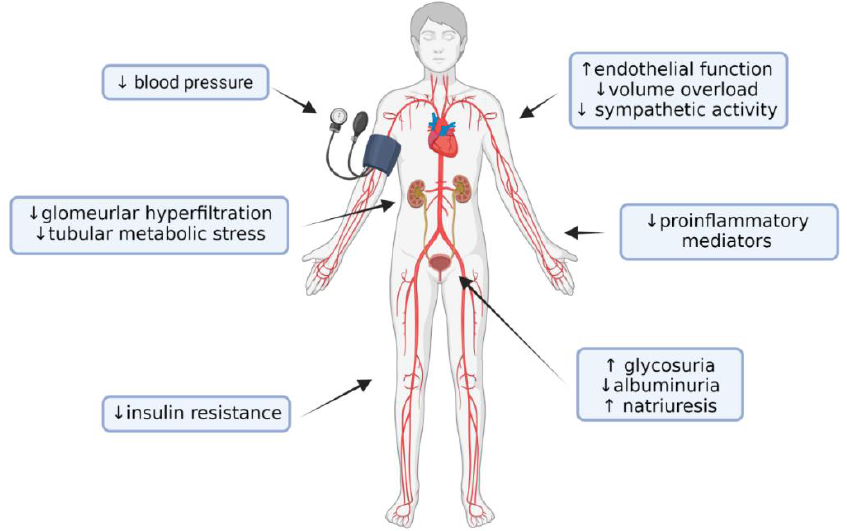
Figure 1. Beneficial systemic effects of SGLT2i with an impact on protection from CKD progression. Created with BioRender.com.